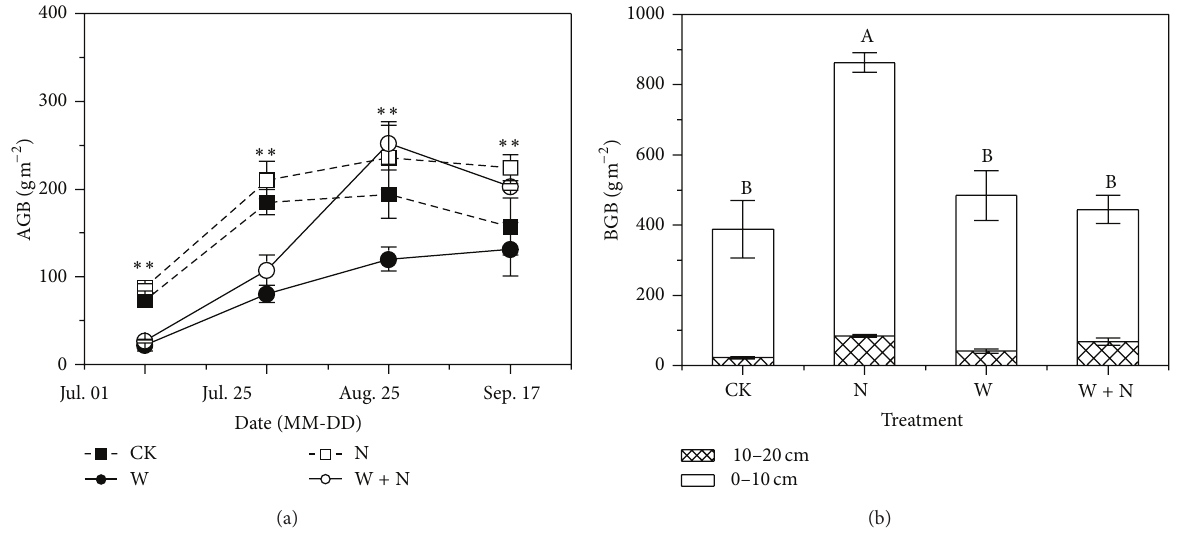
Figure 4: Seasonal variations of plant aboveground and belowground biomass over growing season under different treatments in alpine meadow in 2012. See Figure 2 for the abbreviations of treatments.